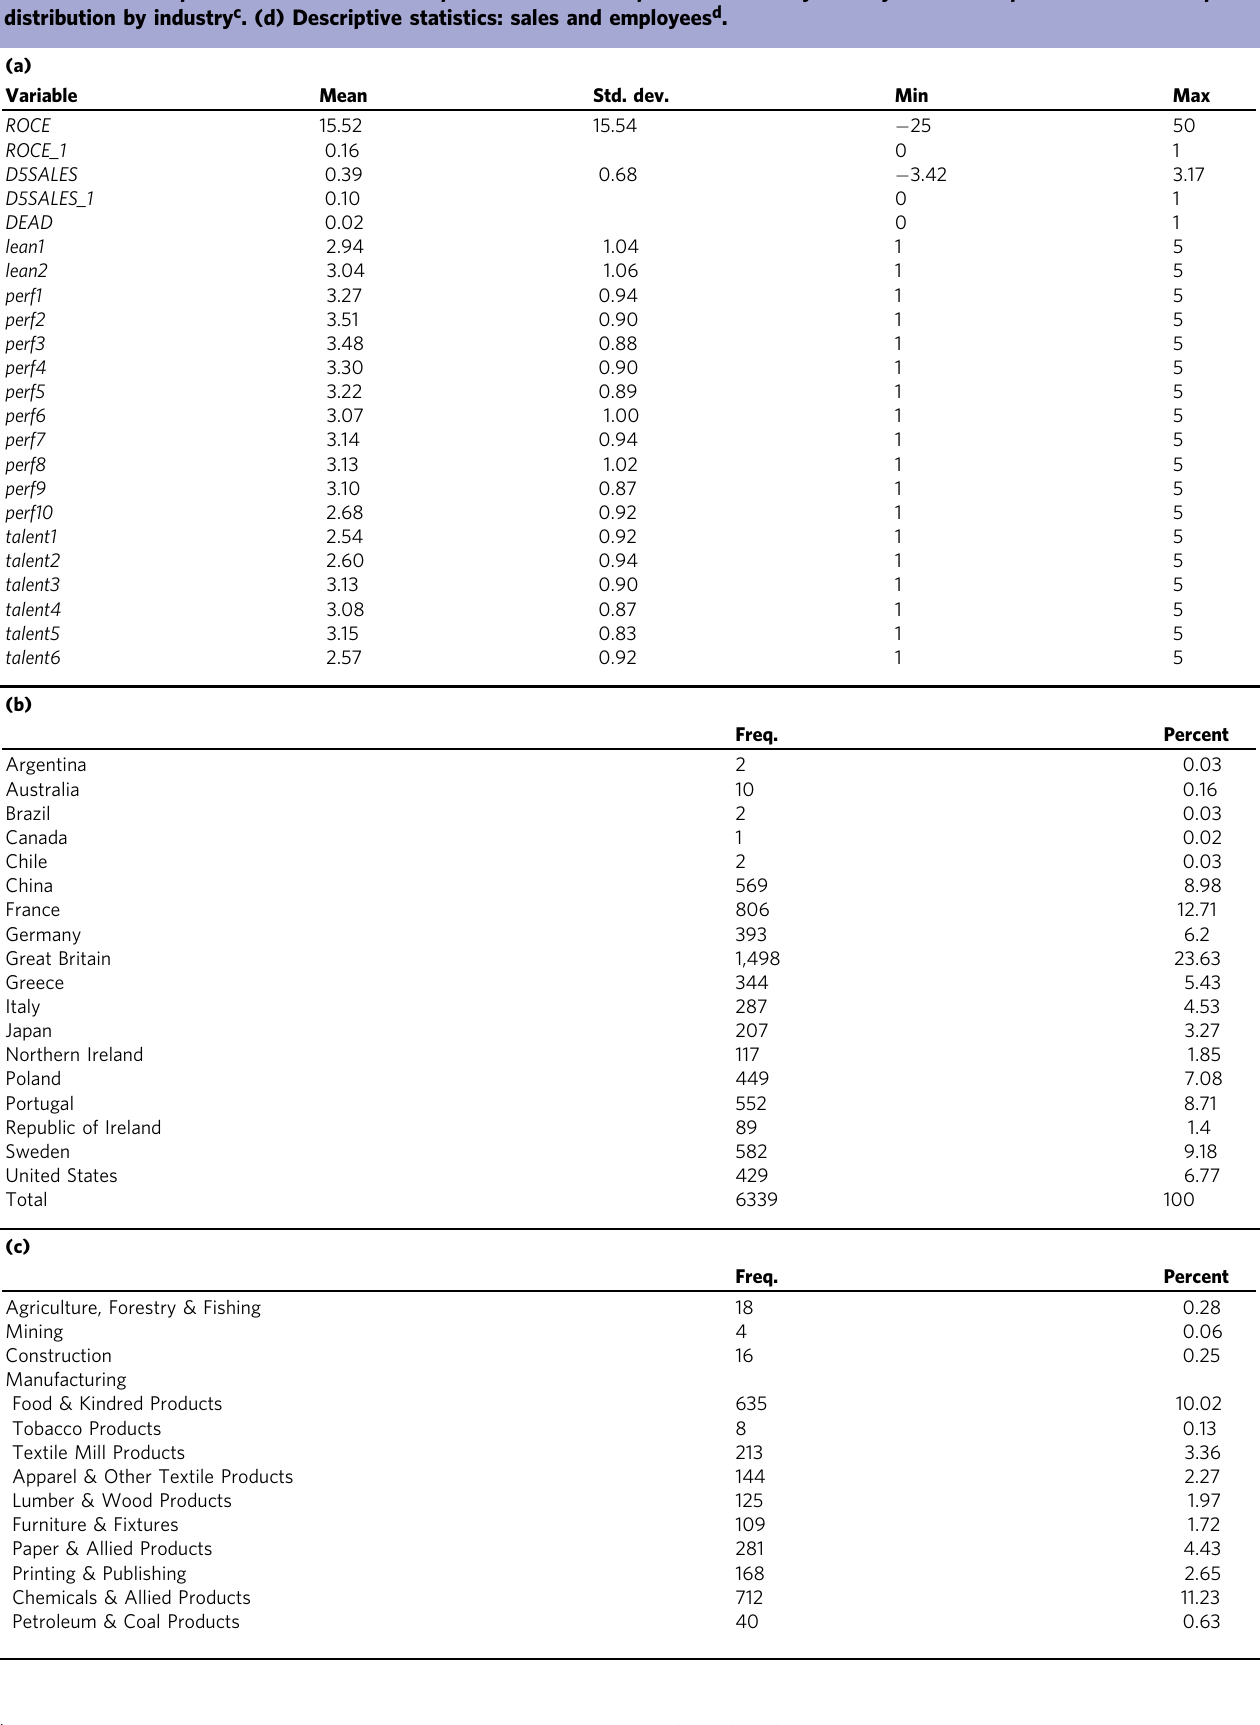
Table 2 (a) Descriptive statistics a . (b) Descriptive statistics: Sample distribution by country b . (c) Descriptive statistics: sample distribution by industry c . (d) Descriptive statistics: sales and employees d .